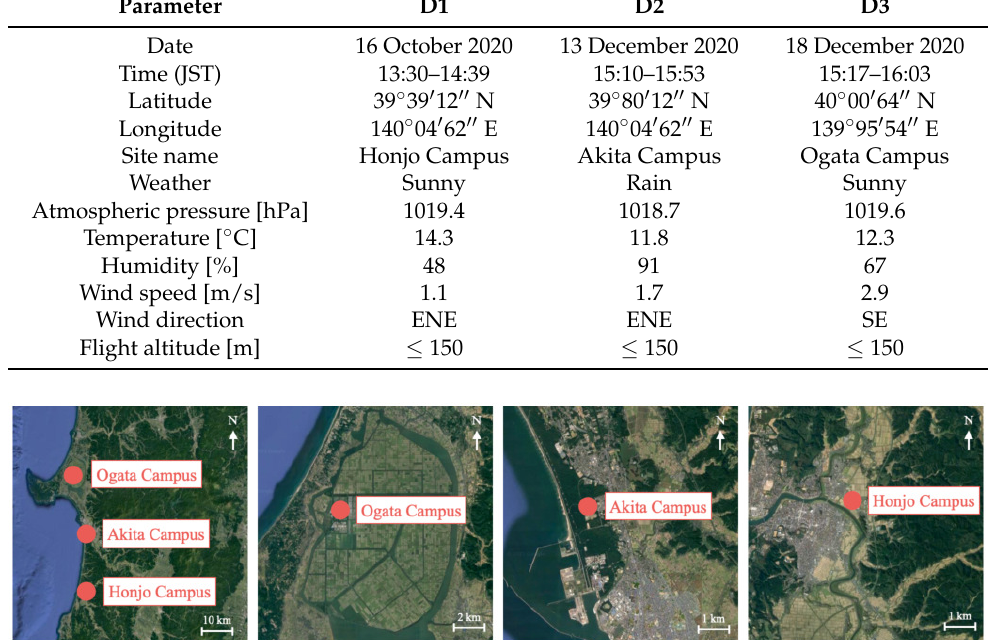
Table 10. Details of flight measurement experiment conditions.